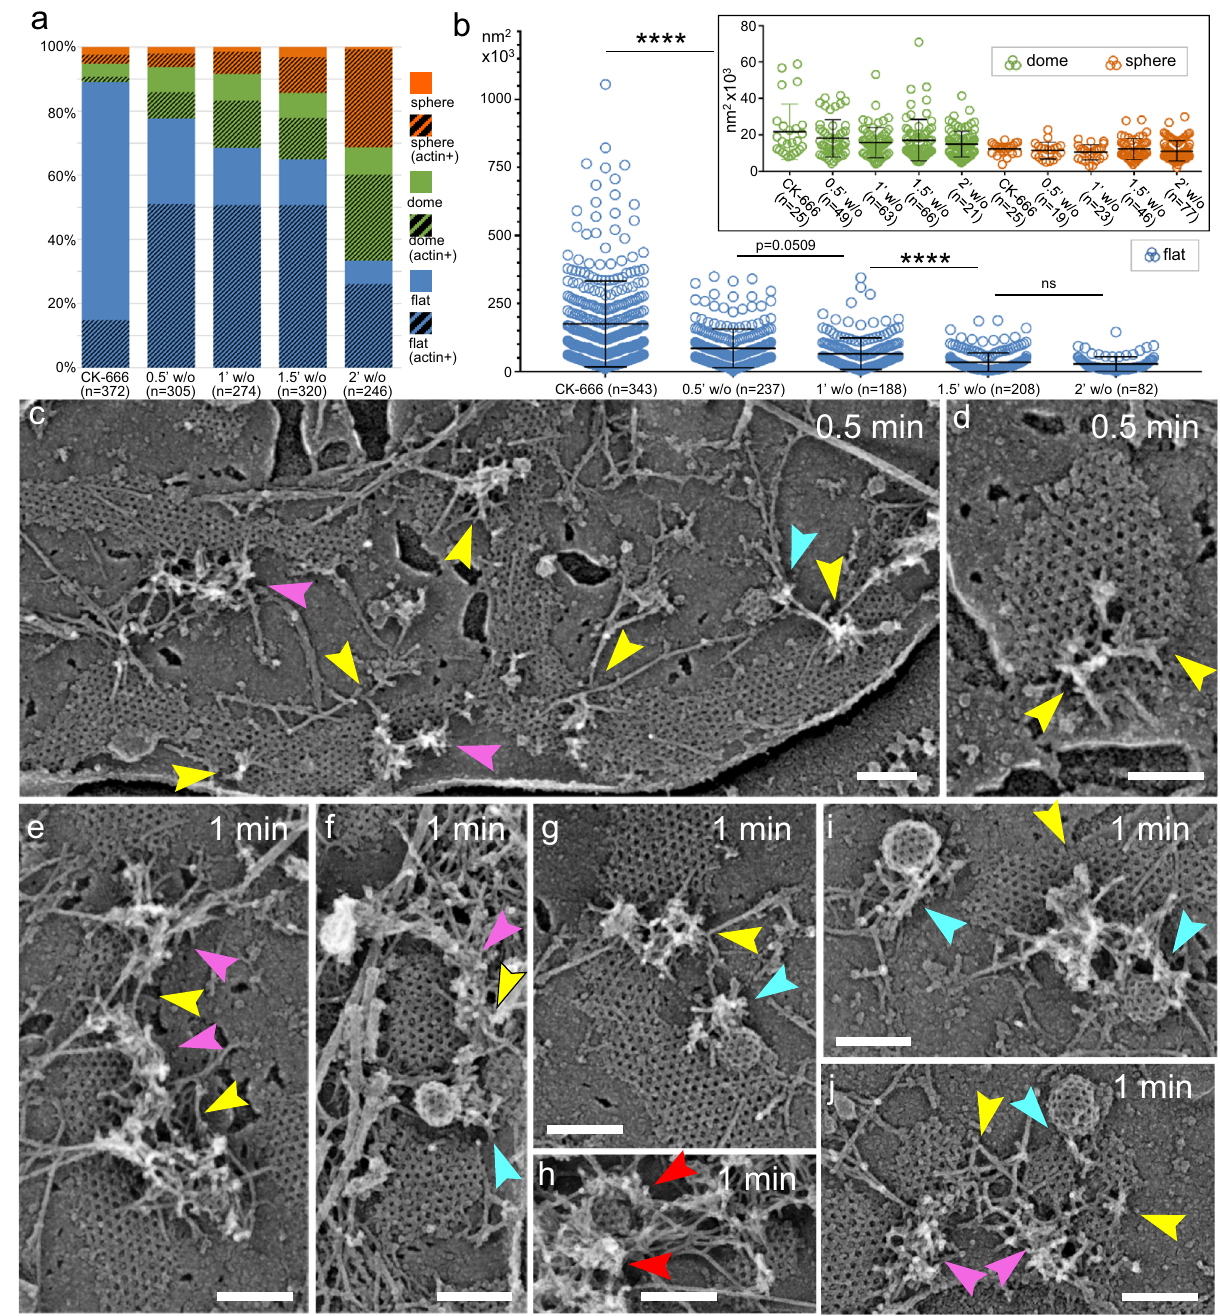
p >0.9999. Kruskal-Wallis with posthoc Dunn ’ s multiple comparison test. Data for CK-666 in ( a ) and ( b ) are the same as in Fig. 3g and h. c – j PREM of PtK2 cells after washout of CK-666 for 0.5min ( c , d ) or 1min ( e – j ). At 0.5min, small patches of branched actin networks appear at the edges of fl at CCS (pink arrowheads), sometimes invading into their “ bays ” and “ seams ” (yellow arrowheads). At 1min, branched actin networks extend along the CCS perimeter (pink arrowheads) and cancompletelysurroundthem(redarrowheads),invadeintobaysandseamsof fl at CCSs(yellowarrowheads),andoccasionallyformcomettailsatdomedorspherical CCSs (cyan arrowheads), usually in immediate vicinity of fl at CCSs. Scale bars,